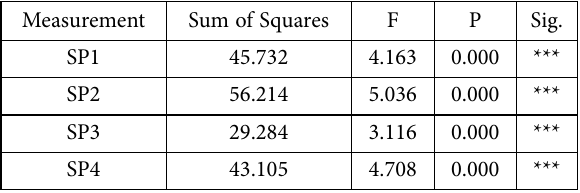
Table 12. One-way analysis of variance of supply-side